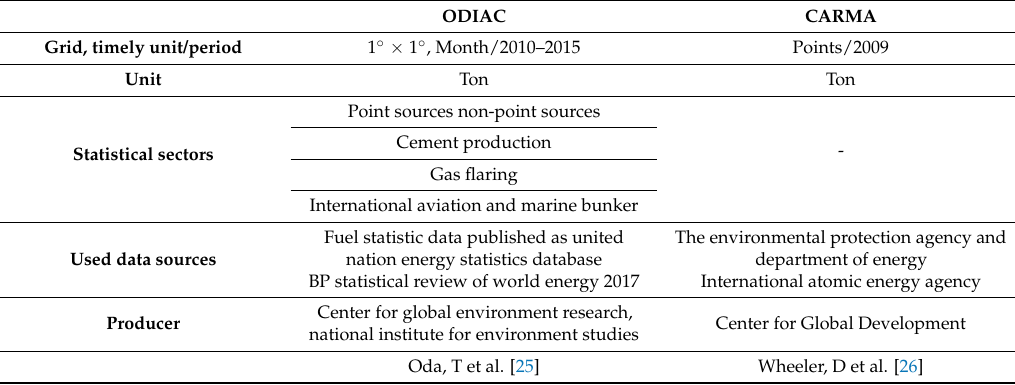
Table 1. Basic specifications of ODIAC and CARMA bottom-up CO 2 emission